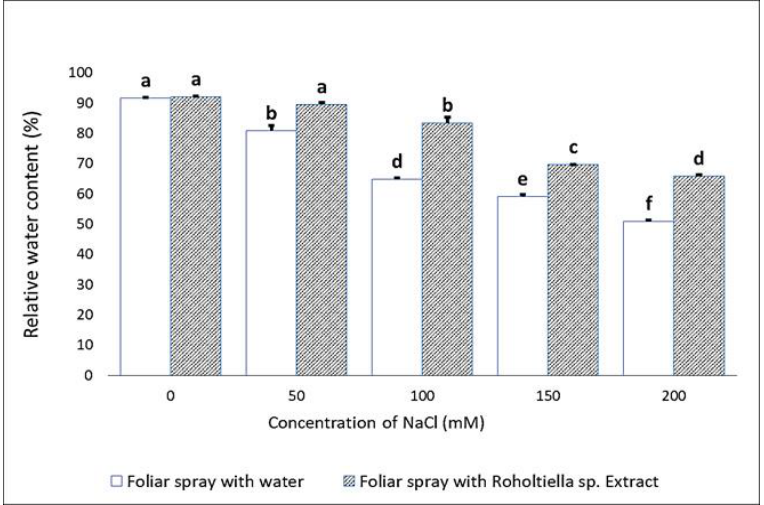
Figure 2. Effect of Roholtiella sp. extract on the relative water content of leaves in salt-stressed bell pepper seedlings. The different letters (a–f) indicate significantly different values in response to the different treatments